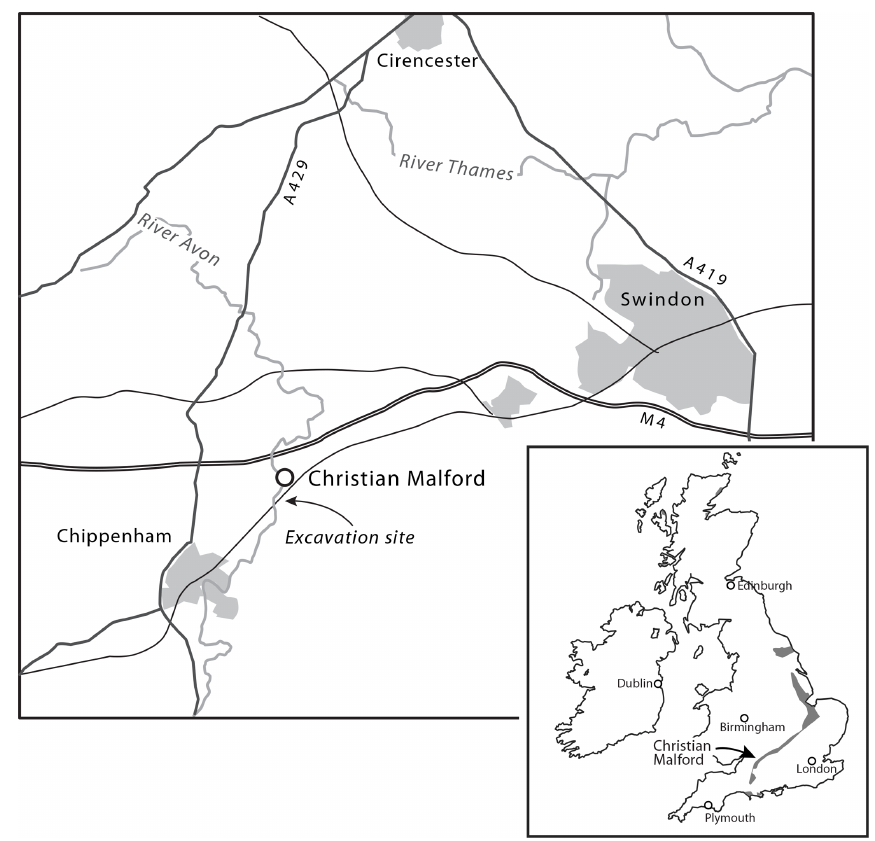
Figure 1. Locality map of Christian Malford (Wiltshire). The excavation site was immediately to the south of the railway line, as near to the original “borrow pits” as